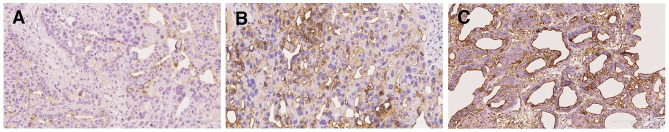
Immunohistochemical staining of S-Lc4 demonstrating differences in intensity. (A) Representative image of weak S-Lc4 immunohistochemical staining represented by High grade serous carcinoma. Scale bar 100 μm. (B) Representative image of moderate immunohistochemical staining represented by Endometrioid adenocarcinoma. Scale bar 100 μm. (C) Representative image of strong immunohistochemical staining represented by Low grade serous carcinoma. Scale bar 200 μm.